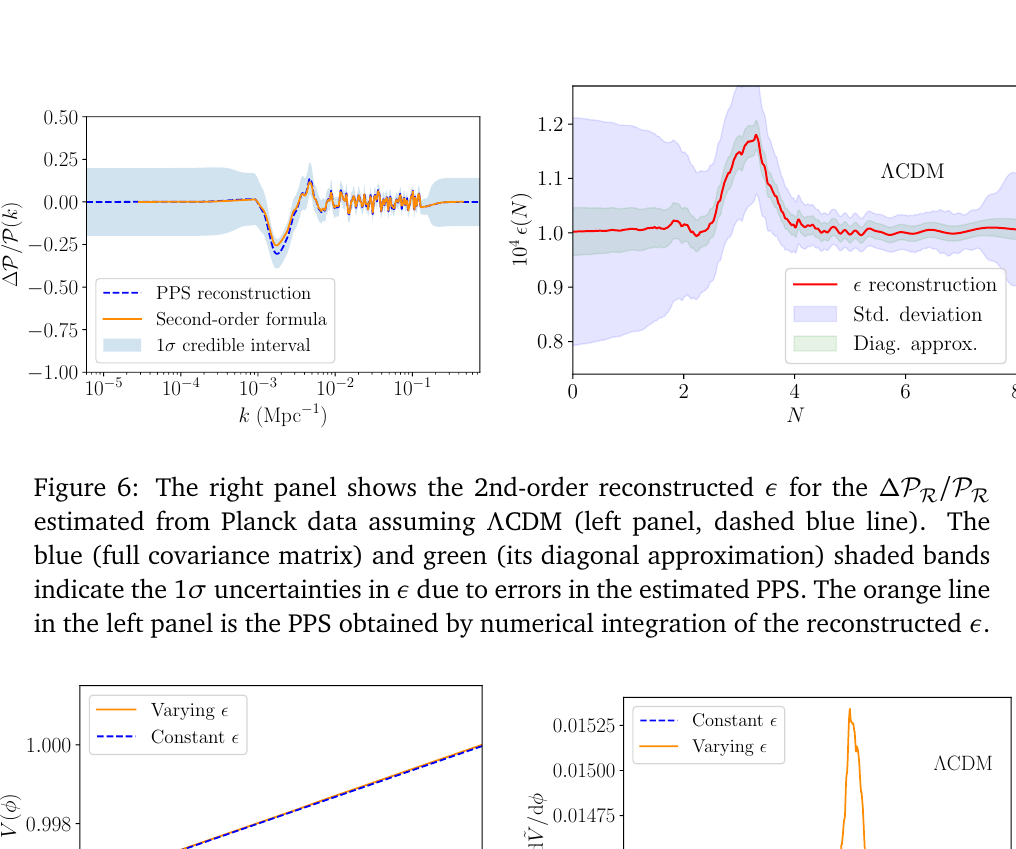
) corresponding to the 0